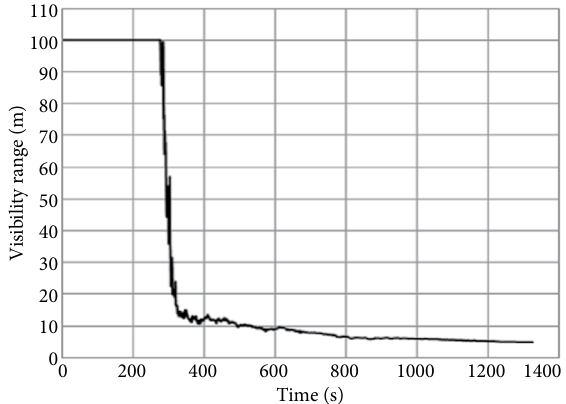
Fig. 18. A view of the remains after combustion (treated timber – on the top, non-treated – on the bottom)